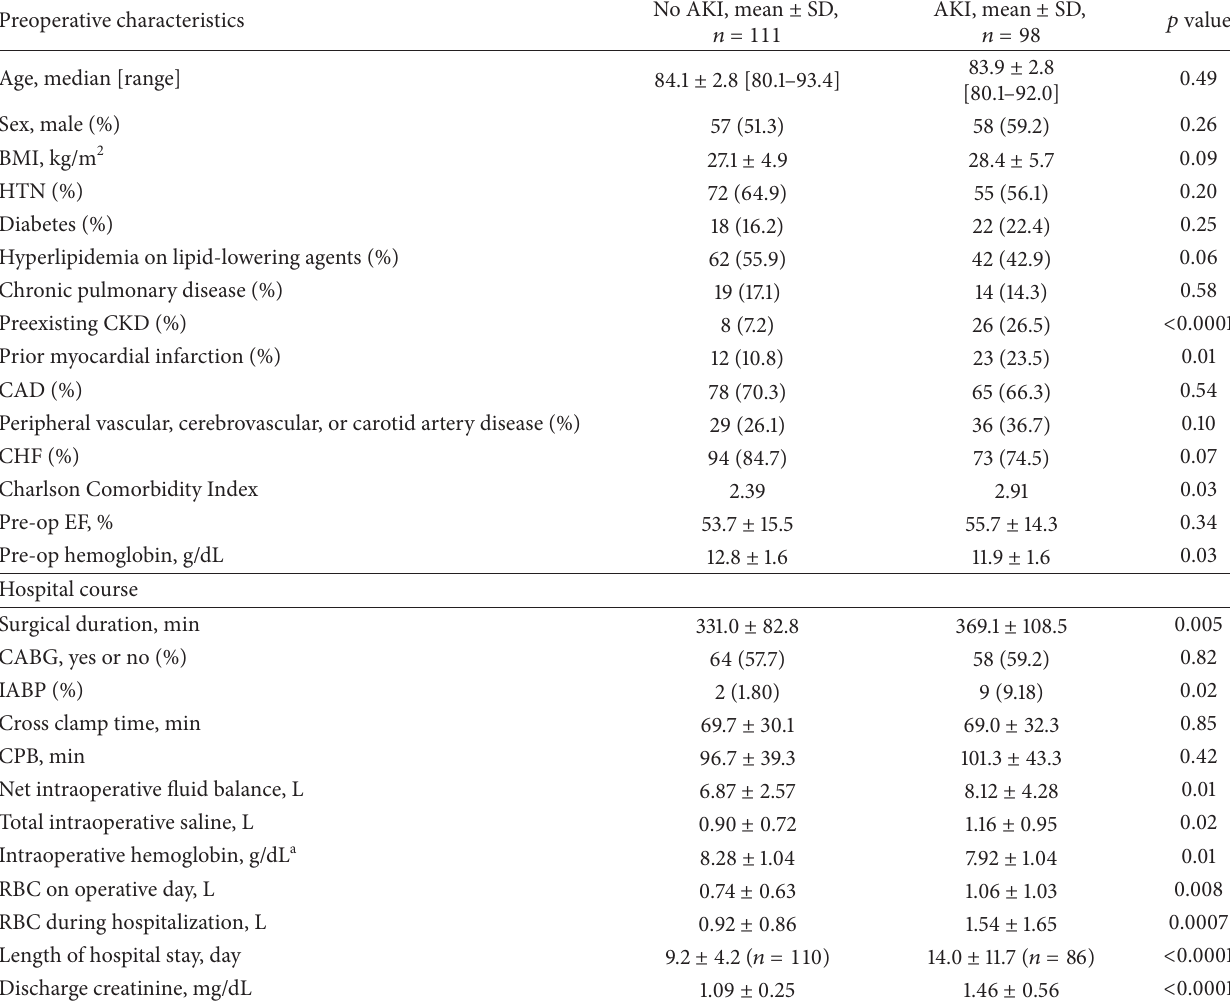
Table 3: Preoperative characteristics and hospital course in AKI and non-AKI octogenarians.